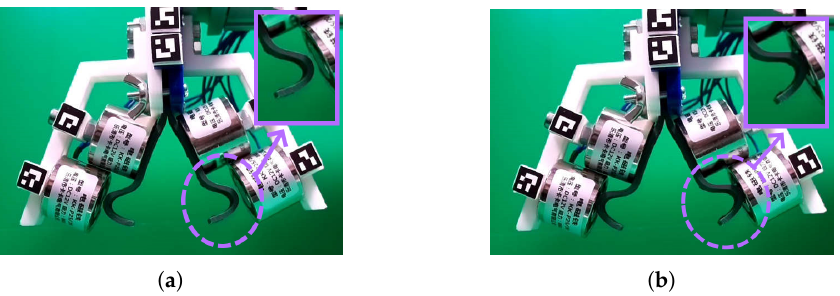
Figure 10. The soft gripper reaction on electromagnet. The upper pair of electromagnets turned on ( a ). The both pairs of electromagnets turned on ( b